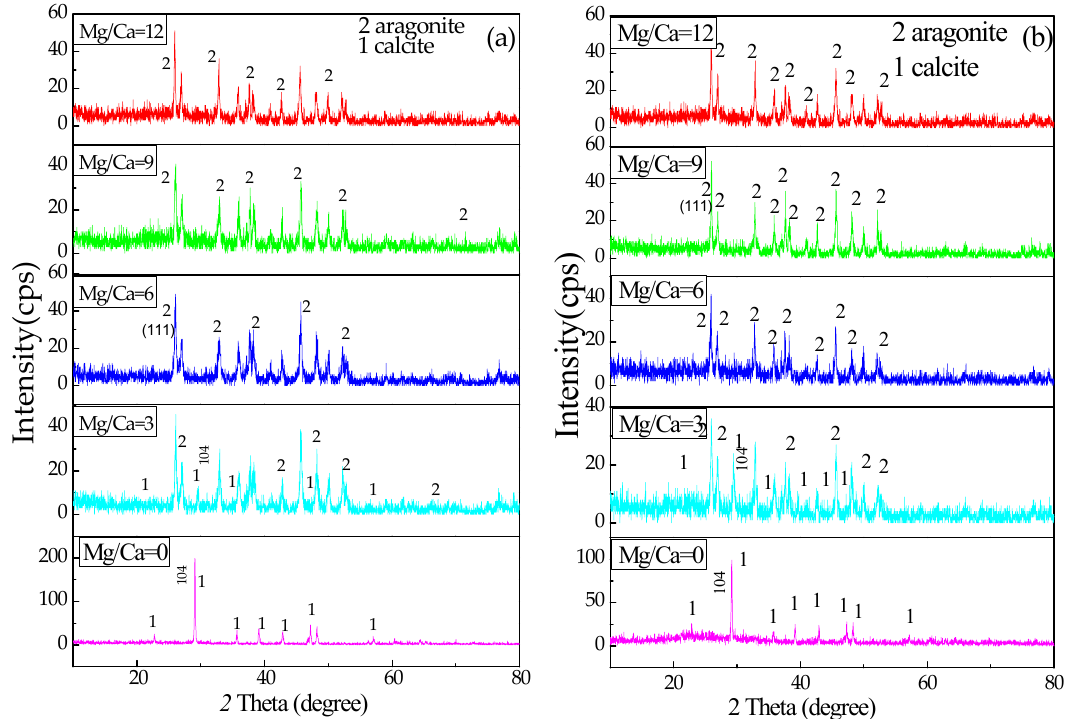
Figure 6. XRD analyses of the minerals induced by B. licheniformis . ( a ) The minerals cultivated for 12 d; ( b ) the minerals cultivated for 24 days.